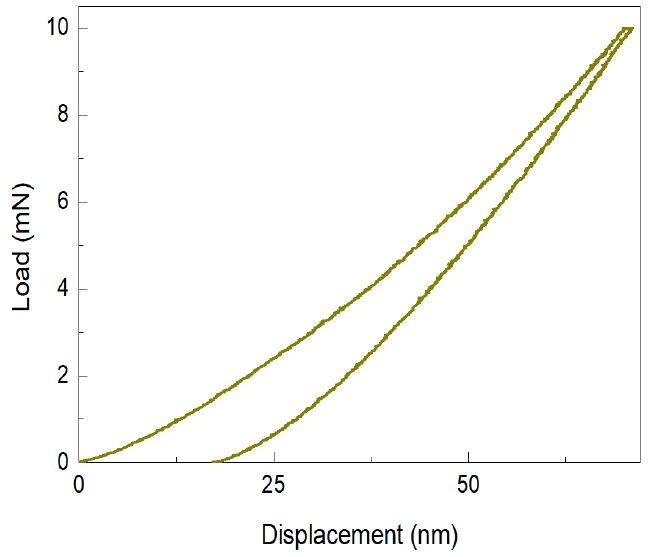
Figure 9. Results of the nanoindentation assay for HfCN coatings deposited on silicon substrates.